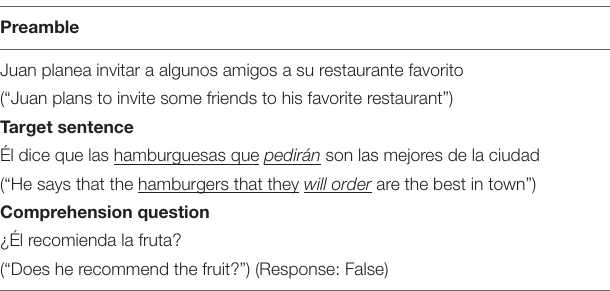
TABLE 1 | Sample materials for one experimental